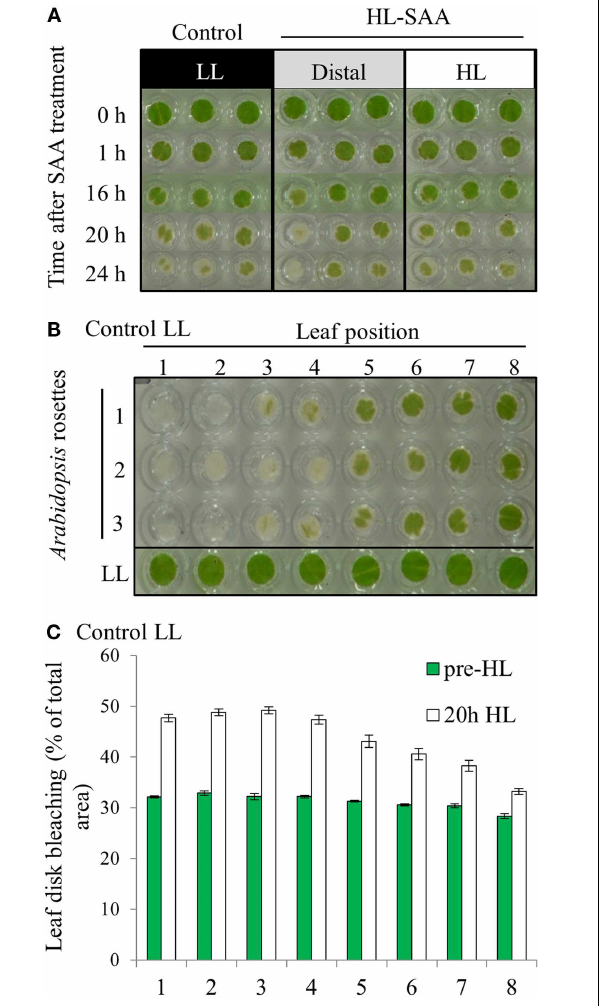
FIGURE 4 | In vitro photo-oxidative tolerance of leaf disks during HL SAA and control LL conditions. (A) Representative image of leaf disks sampled from LL (black), HL spot treated leaves (white), and distal leaves (gray). (B) Leaf disk assay of basal resistance to photo-oxidative stress across the Arabidopsis rosette in leaves under control LL growth conditions. (C) Analysis of (B) using ImageJ software to distinguish between bleached (white) and unbleached (green) tissues. Plants were either treated to HL spot treatment or remained under LL condition, as explained in Section “Material and Methods.” Following treatment leaf disks were floated on H 2 O 2 (0.5M) in a 96-well plate, HL-treated for 60mins, then returned to 150 µ molphotonsm − 2 s − 1 for 24h. Photographs were taken throughout the 24-h period, experiment was performed in triplicate, n =